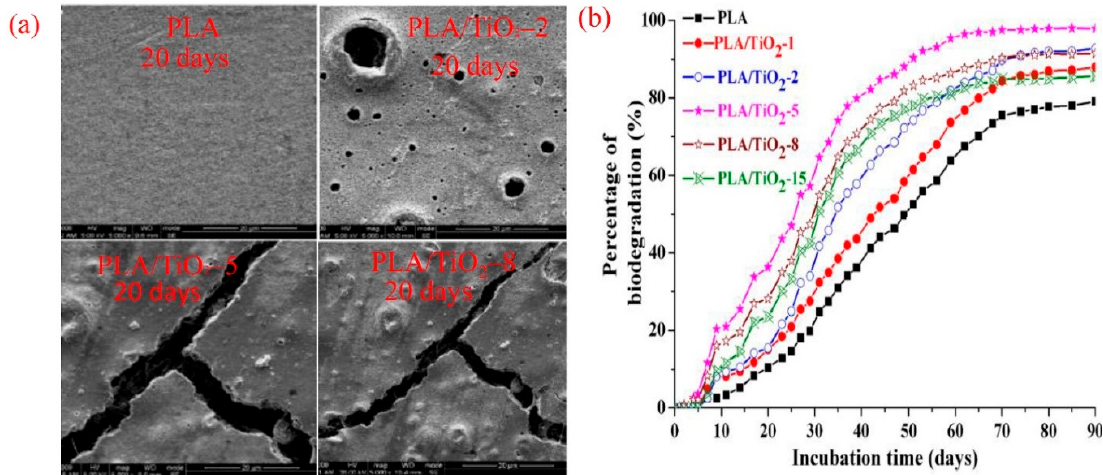
Figure 8. ( a ) SEM images of PLA and PLA/TiO 2 -2, PLA/TiO 2 -5, and PLA/TiO 2 -8 composites after 20 days incubation time and ( b ) the percentage of biodegradation with respect to incubation time for pure PLA and PLA/TiO 2 composites